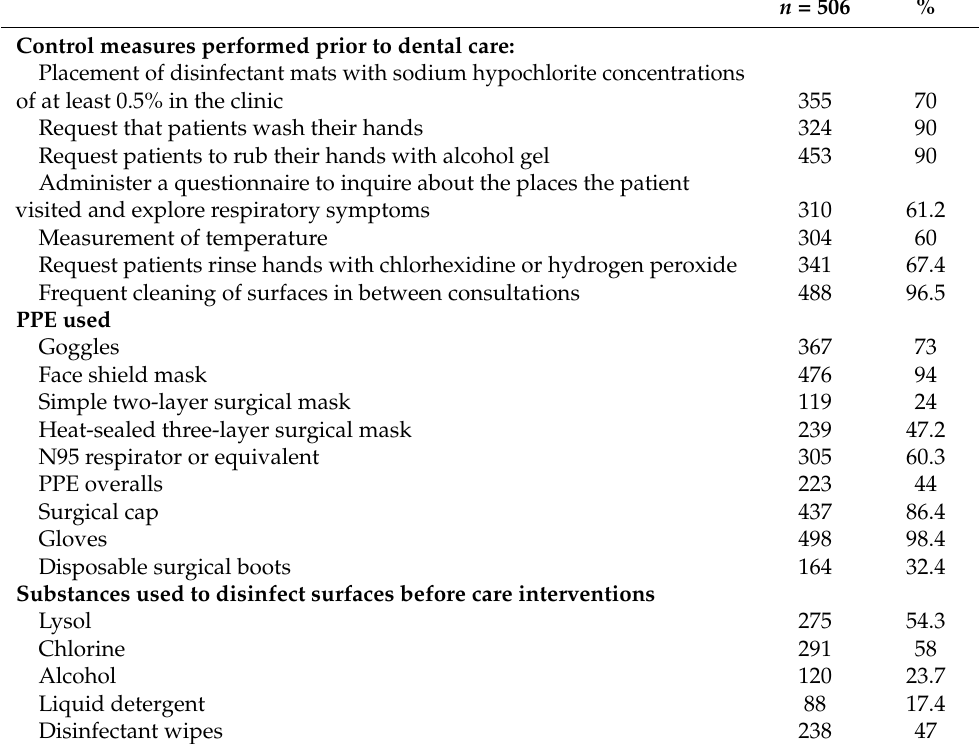
Table 4. Prevention of transmission during clinical dental care (multiple selections